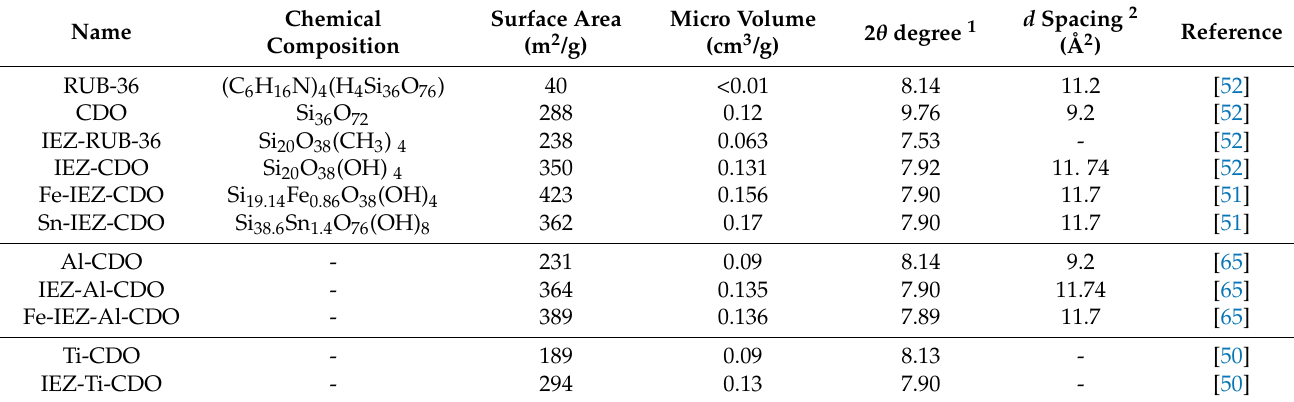
Table 3. Textural parameters of RUB-36 and the related